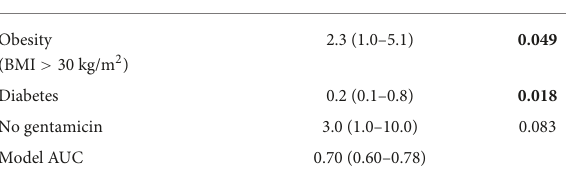
TABLE 5 Summary of logistic regression model predicting the presence of any major or minor